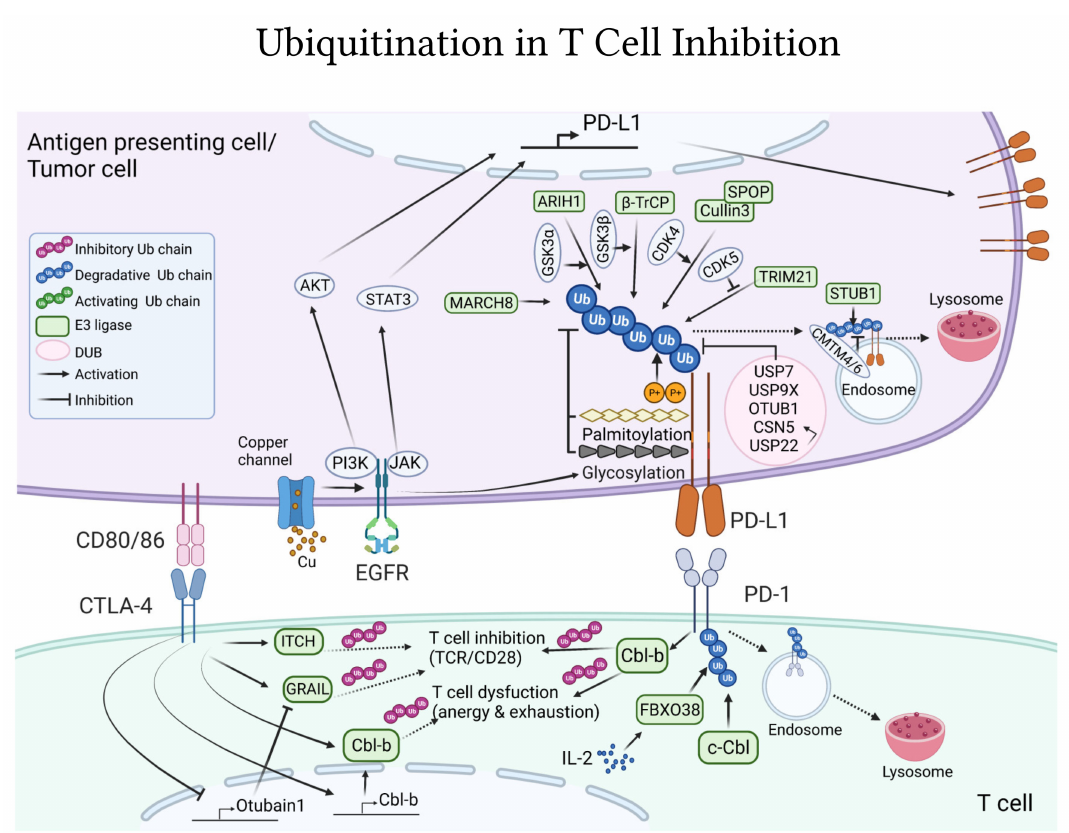
Figure 3. Ubiquitination in the CTLA-4 and PD-1/PD-L-1 checkpoint inhibitory receptors. Upon interaction with their cognate ligands on the cell surface of APCs or tumor cells, T-cell co-inhibitory receptors such as CTLA-4 and PD-1 impair T-cell activation to shut down the immune response and permit tissue repair. The ubiquitin system controls the function and stability of these receptors through degradative (blue) and non-degradative chains (purple), significantly impacting the outcome of these signaling events. Ub: ubiquitin; P+ (orange circle): phosphorylated residues; ARIH1: ariadne RBR E3 ubiquitin protein ligase 1; AKT: serine/threonine-protein kinase/ protein kinase B; Cbl-b: casitas B-lineage lymphoma proto-oncogene B; c-Cbl: casitas B-lineage lymphoma proto-oncogene C; CDK4: cyclin-dependent kinase 4; CDK5: cyclin- dependent kinase 5; CMTM4/6: CKLF-like MARVEL transmembrane domain containing 4/6; CSN5: COP9 signalosome complex subunit 5; CTLA-4: cytotoxic T-lymphocyte-associated protein 4; Cu: Copper ions; EGFR: epidermal growth factor receptor; FBXO38: F-box protein 38; GRAIL: gene related to anergy in lymphocytes; GSK3 α : glycogen synthase kinases α ; GSK3 β : glycogen synthase kinases β ; IL2: interleukin 2; ITCH: itchy E3 ubiquitin protein ligase; JAK: janus kinase; MARCH8: membrane-associated ring finger 8; OTUB1: OTU domain-containing ubiquitin aldehyde-binding protein 1; PD-1: programmed cell death protein 1; PD-L1: programmed death-ligand 1; PI3K: phosphoinositide 3-kinase; SPOP: speckle type BTB/POZ protein; STAT3: signal transducer and activator of transcription 3; STUB1: STIP1 homology and U-box containing protein 1; TRIM21: tripartite motif containing 21; USP7/22/9X: ubiquitin specific peptidase (USP) 7/22/9X-Linked, respectively; β -TrCP: beta-transducin repeat containing E3 ubiquitin protein ligase. Illustration created using BioRender